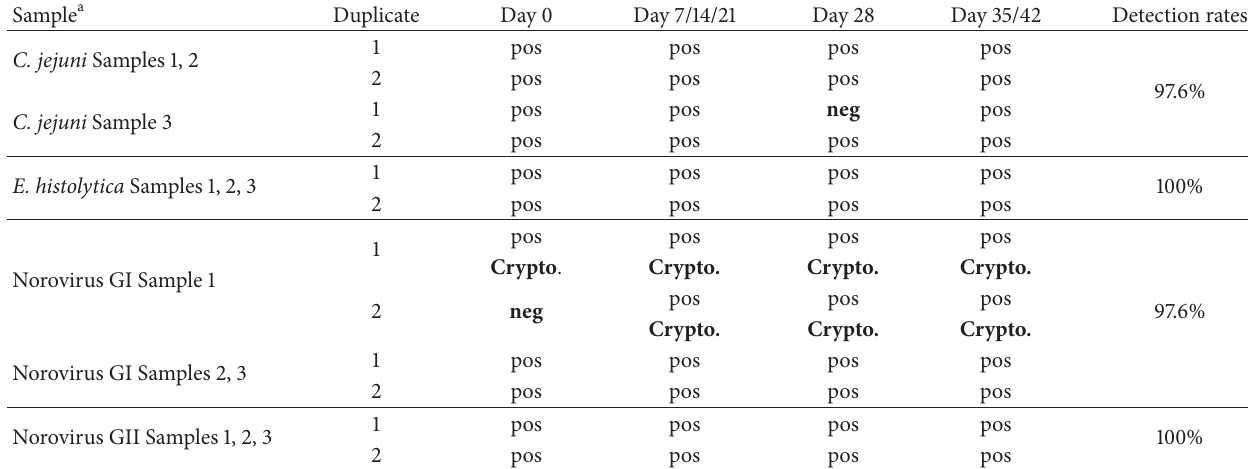
Table 2: Results of the storage trial for C. jejuni , E . histolytica , and norovirus GI/II. Sample